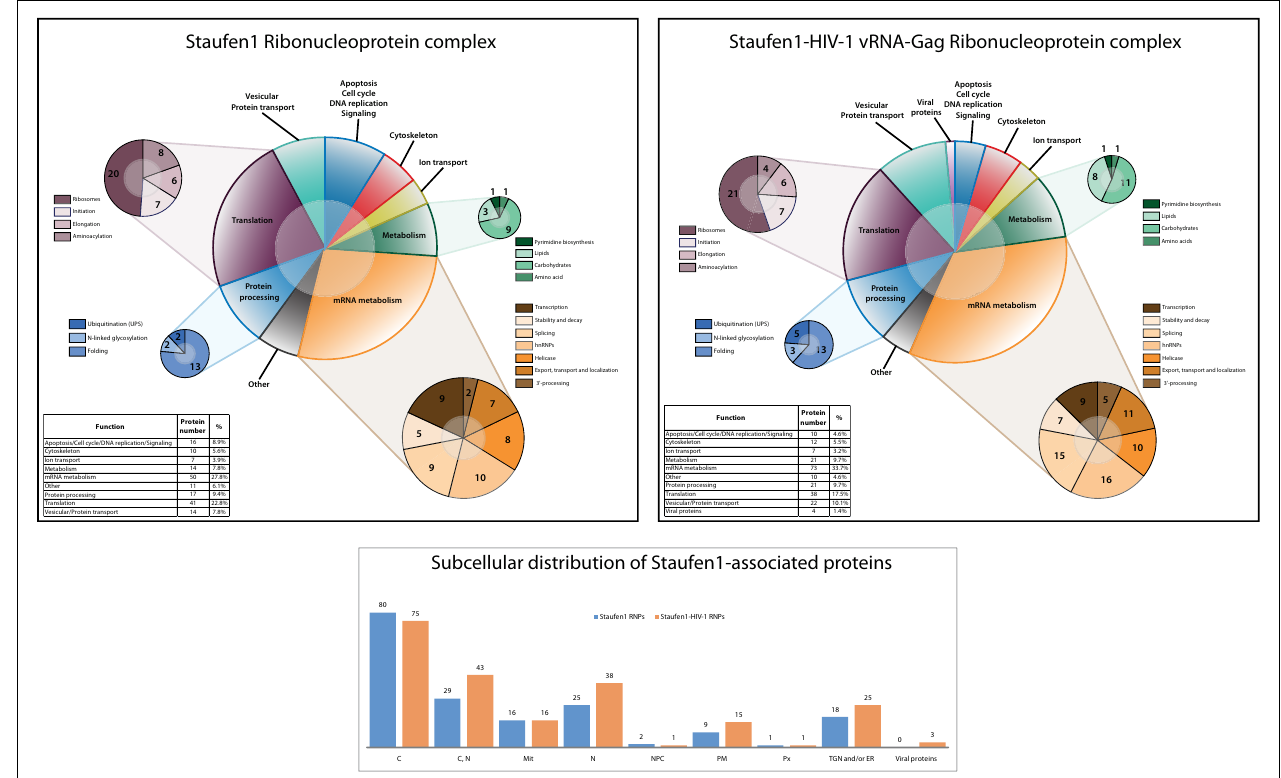
their main function or the process in which they are involved in both control and HIV-1 conditions.The subcellular distribution of proteins found in Staufen1-TAP (blue bars) and Staufen1-TAP HIV-1 (orange bars) RNPs is depicted (bottom panel).The information for each protein was obtained from the UniProt